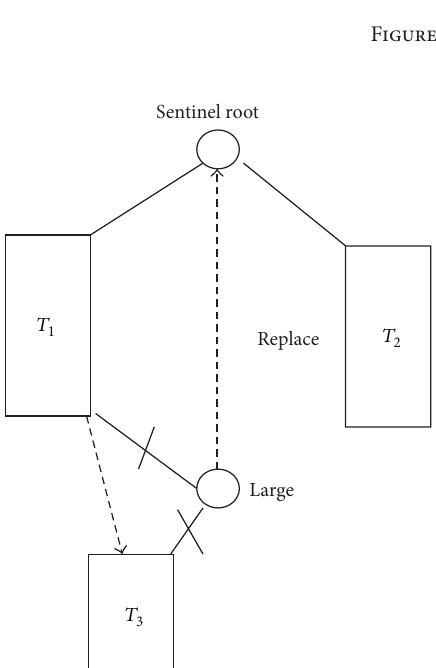
Figure 3: Lookup for key 1 on node 0.